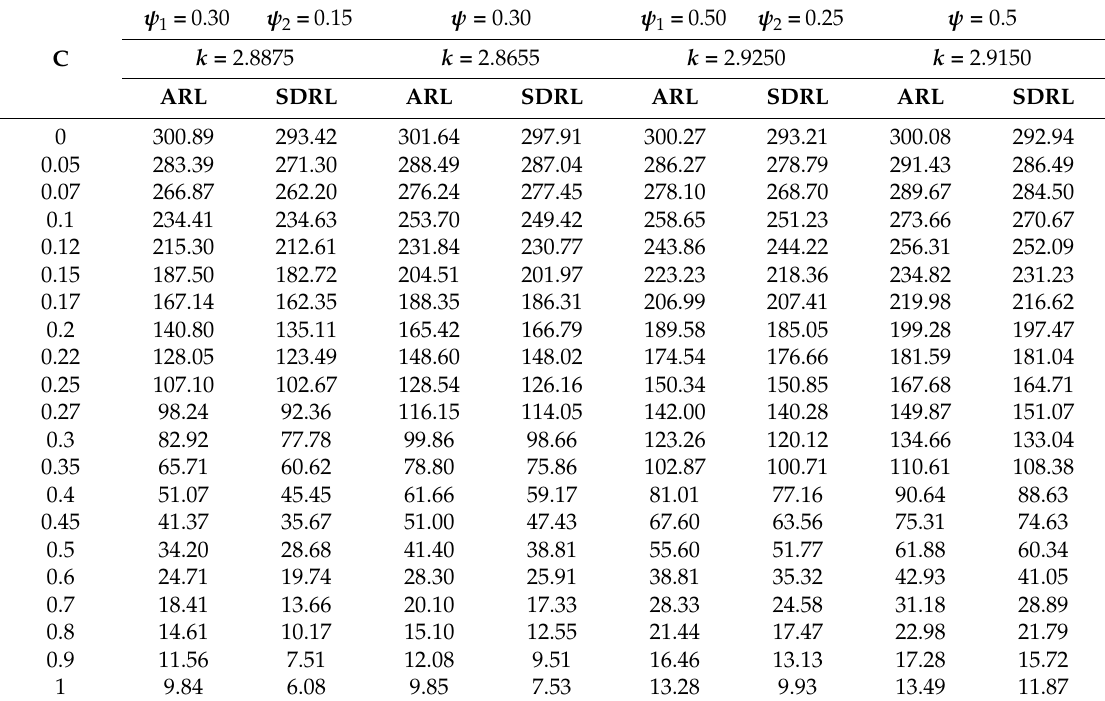
Table 6. The ARL, SDRL values of the proposed EEWMA and EWMA control charts for various shifts when r 0 =